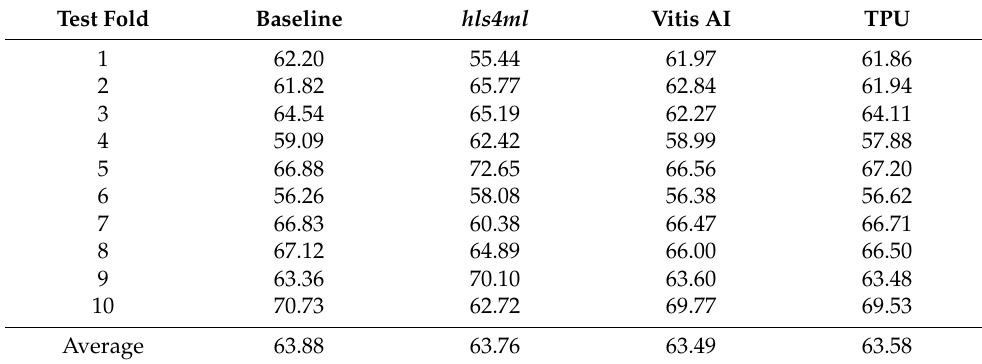
Table 15. Accuracy (in %) for each fold and average accuracy across all 10 folds of the UrbanSound8k dataset for the different tool flows with the CNN2D model after